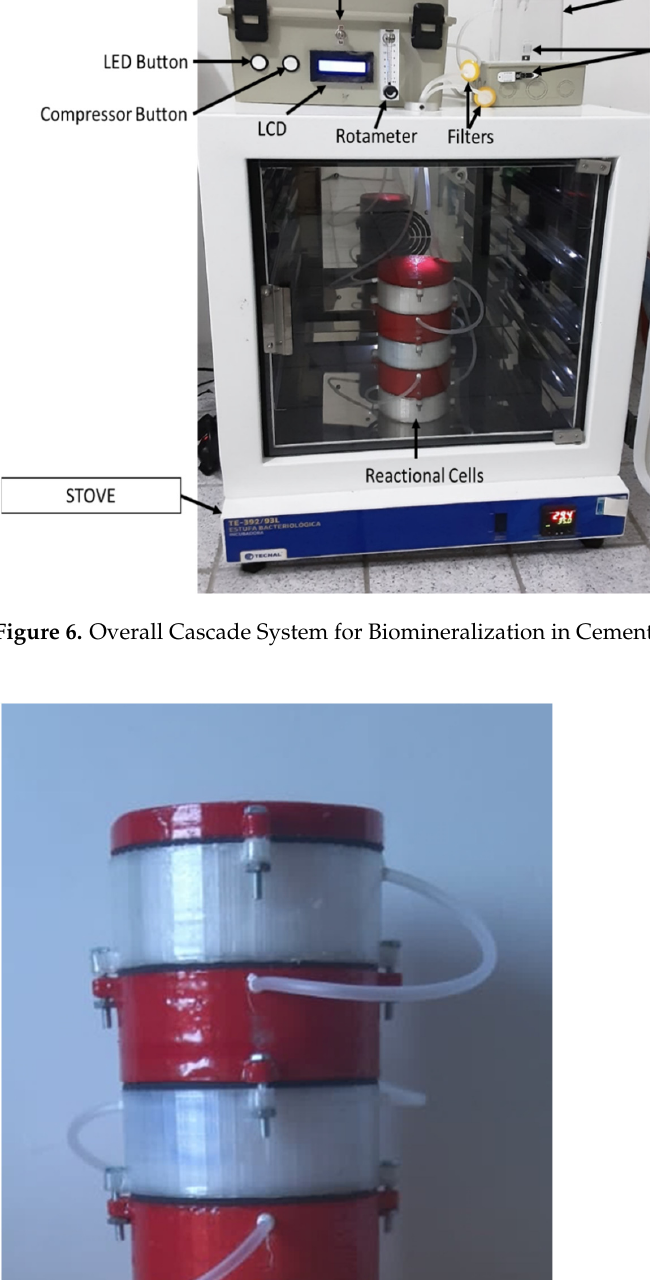
Figure 7. Reaction cells of the Cascade System for Biomineralization in Cement.